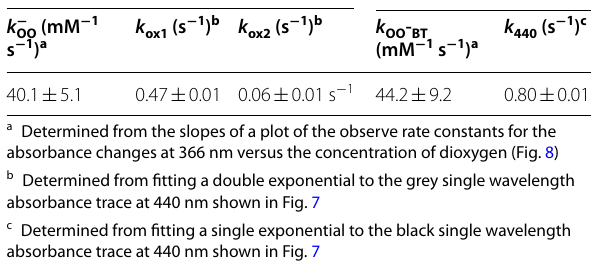
Table 3 Observed rate constants for the oxidative half reaction. The reactions were performed in 50 mM HEPES– NaOH, pH 7.5 at 25